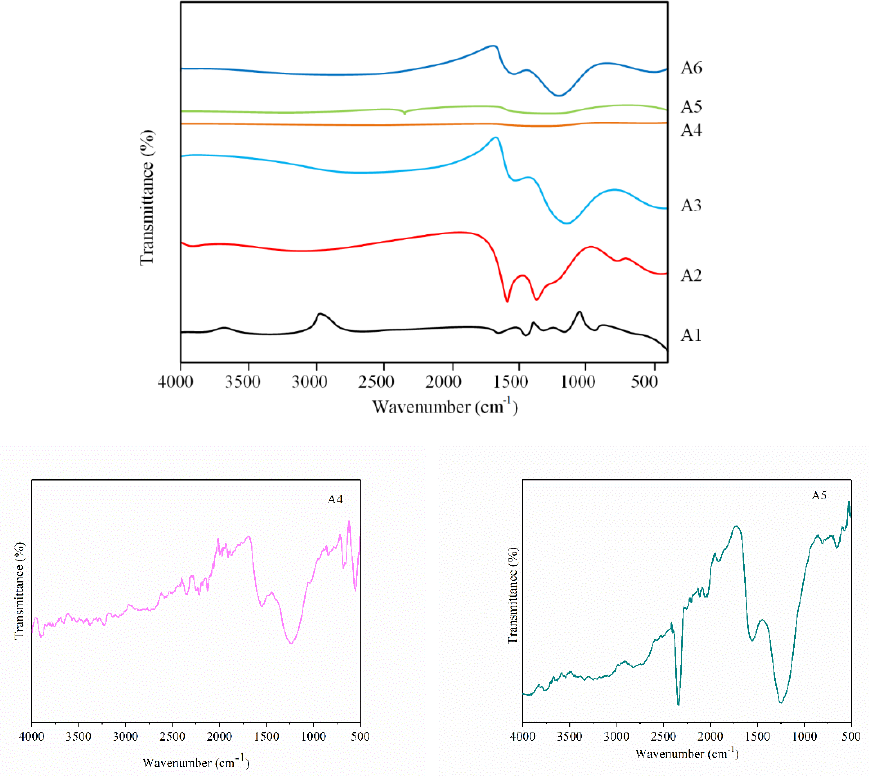
Figure 5. Infrared spectrogram of samples A1 – A6.